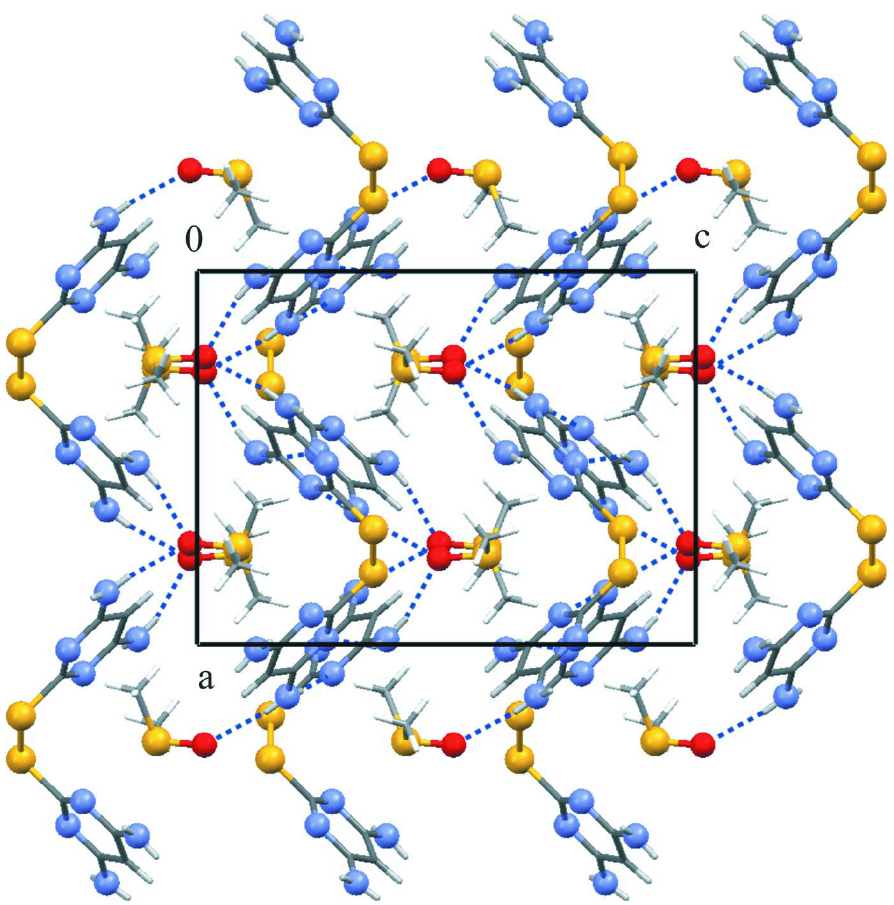
Figure 2 The crystal structure of (I) viewed down the b axis. Hydrogen bonds are shown with dashed